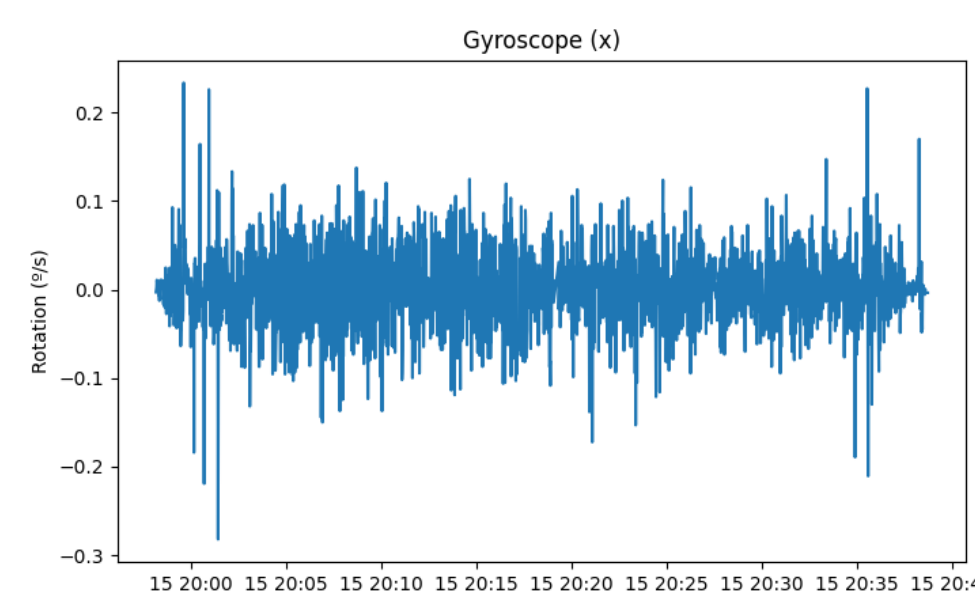
Figure 22. Rotation of the smartphone in the x-axis.